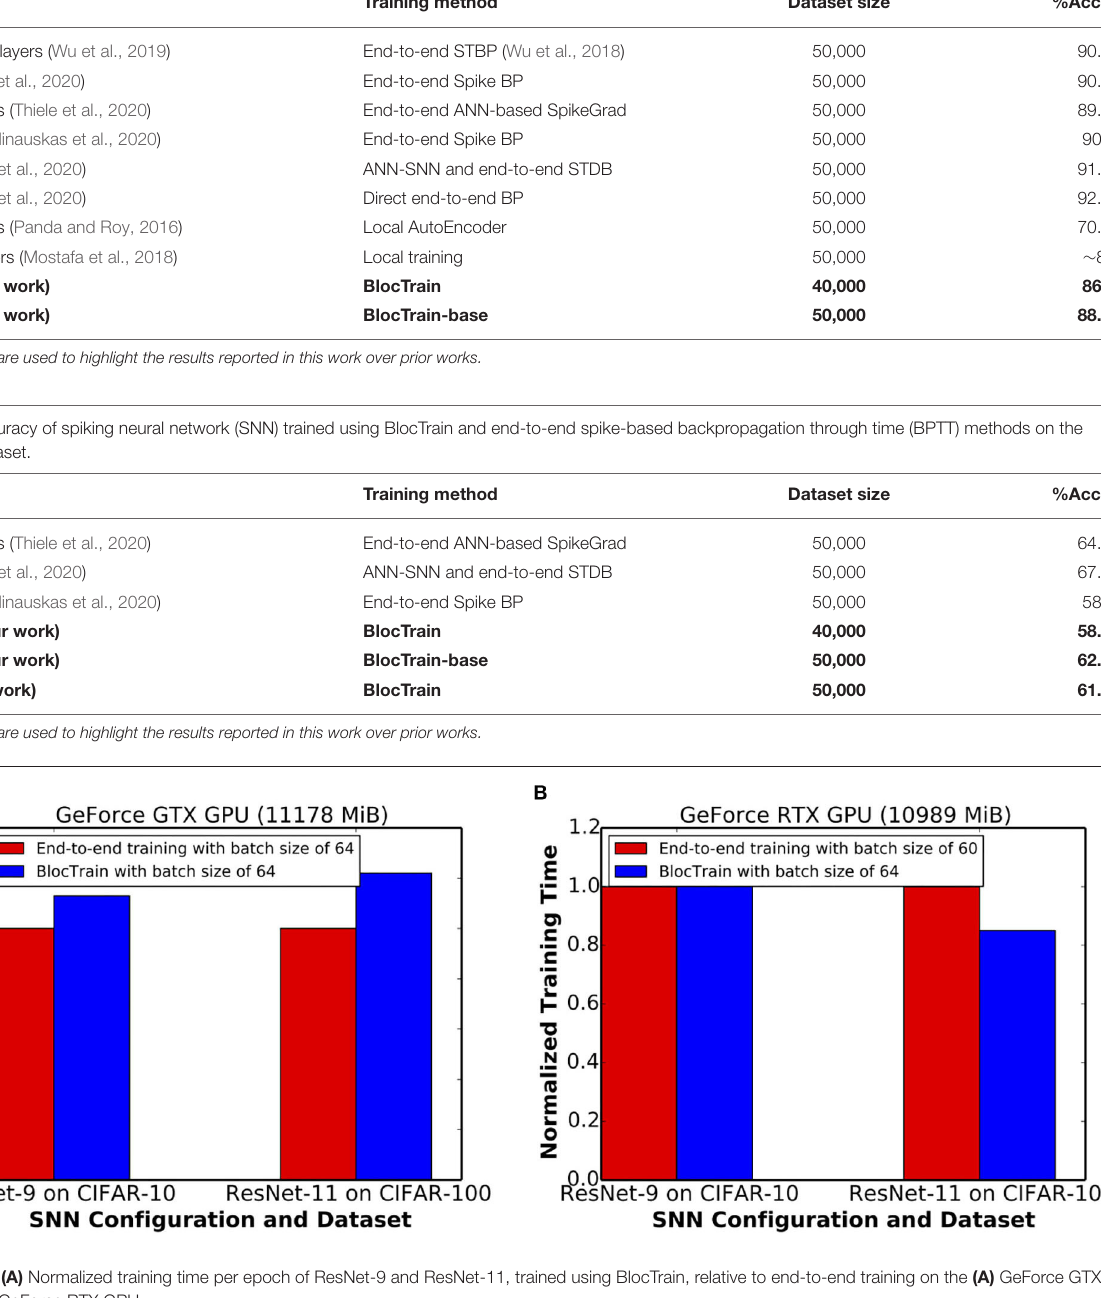
TABLE 1 | Accuracy of spiking neural network (SNN) trained using BlocTrain and end-to-end spike-based backpropagation through time (BPTT) methods, and SNN/analog neural network (ANN) trained using only the local losses, on the CIFAR-10 dataset. Model